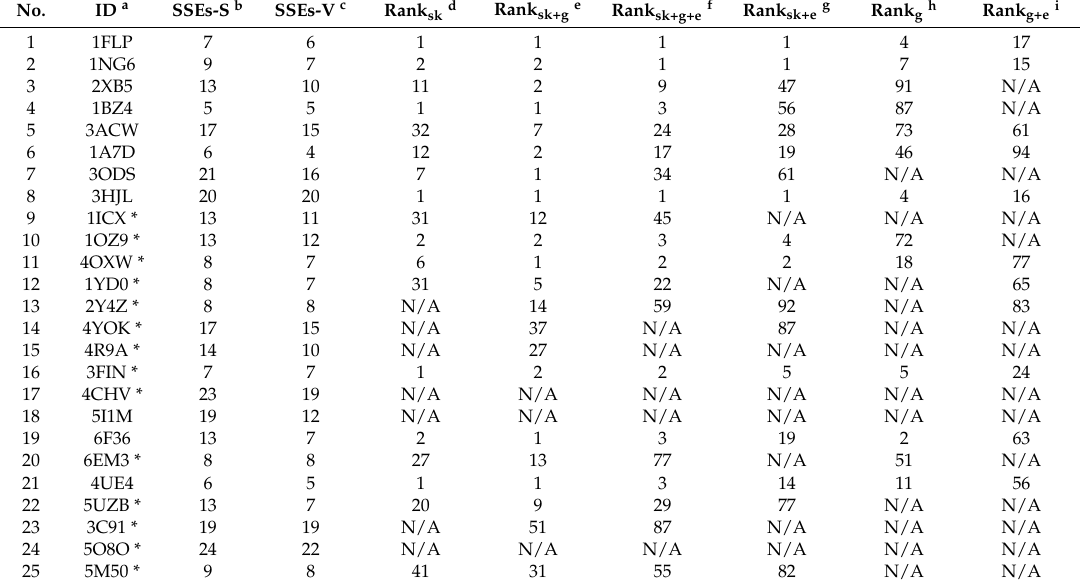
Table 2. The performance of DP-TOSS with different scoring